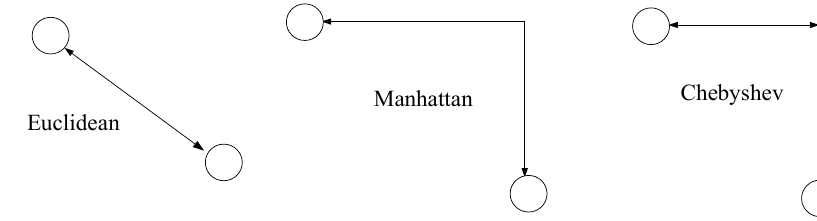
Figure 1. Diagram of distance measurement methods.